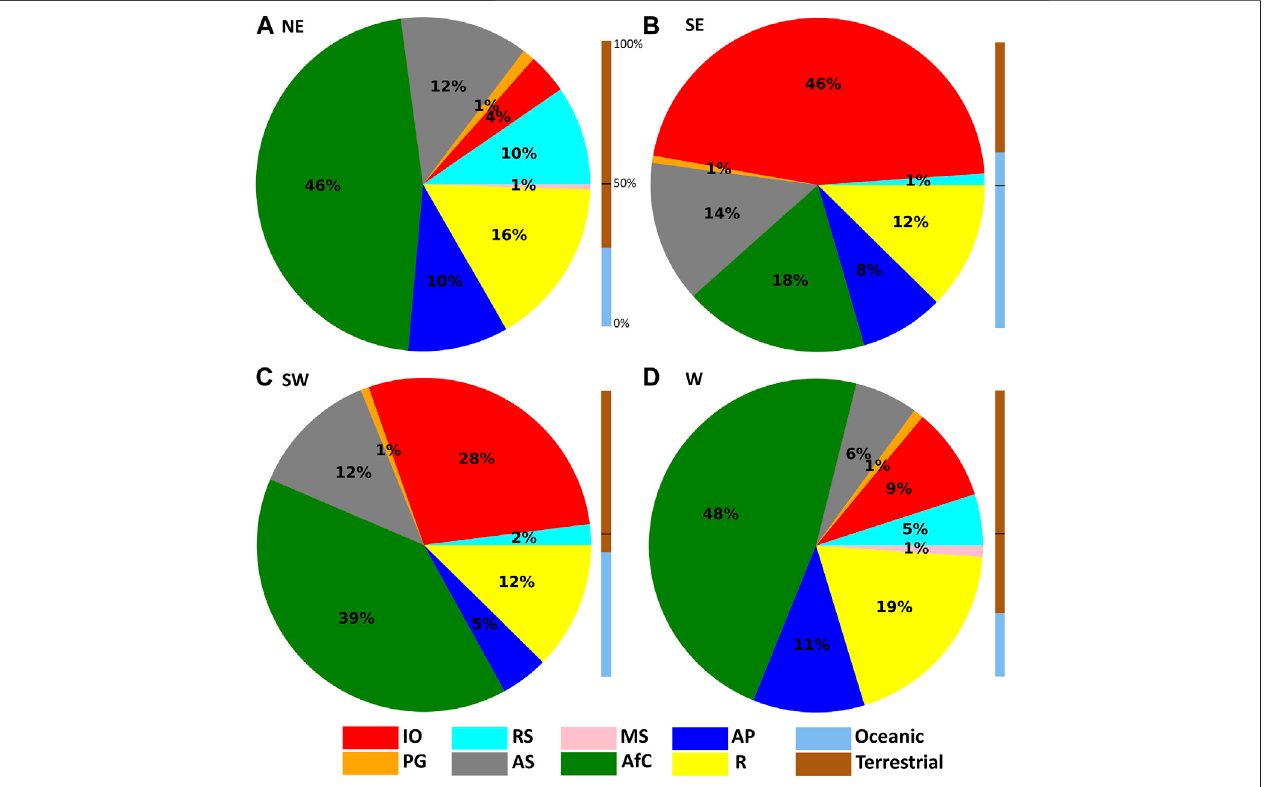
FIGURE 6 | Percentages of moisture contribution (E − P < 0) from different sources to the four Ethiopian river basin regions: (A) northeast (NE), (B) southeast (SE), (C) southwest(SW),and (D) western(W),obtained via theforwardanalysisfortheperiod1980 – 2018.Blueandbrownbarsrepresentthetotalmoisturecontributionfrom oceanic and terrestrial sources, respectively. Key for the sources: IO, Indian Ocean (red), RS, Red Sea (cyan), MS, Mediterranean Sea (pink), PG, Persian Gulf (orange), AS, Arabian Sea (grey), AfC, African continent (green), AP, Arabian Peninsula (dark blue), and R, within the region ’ s river basins (yellow).